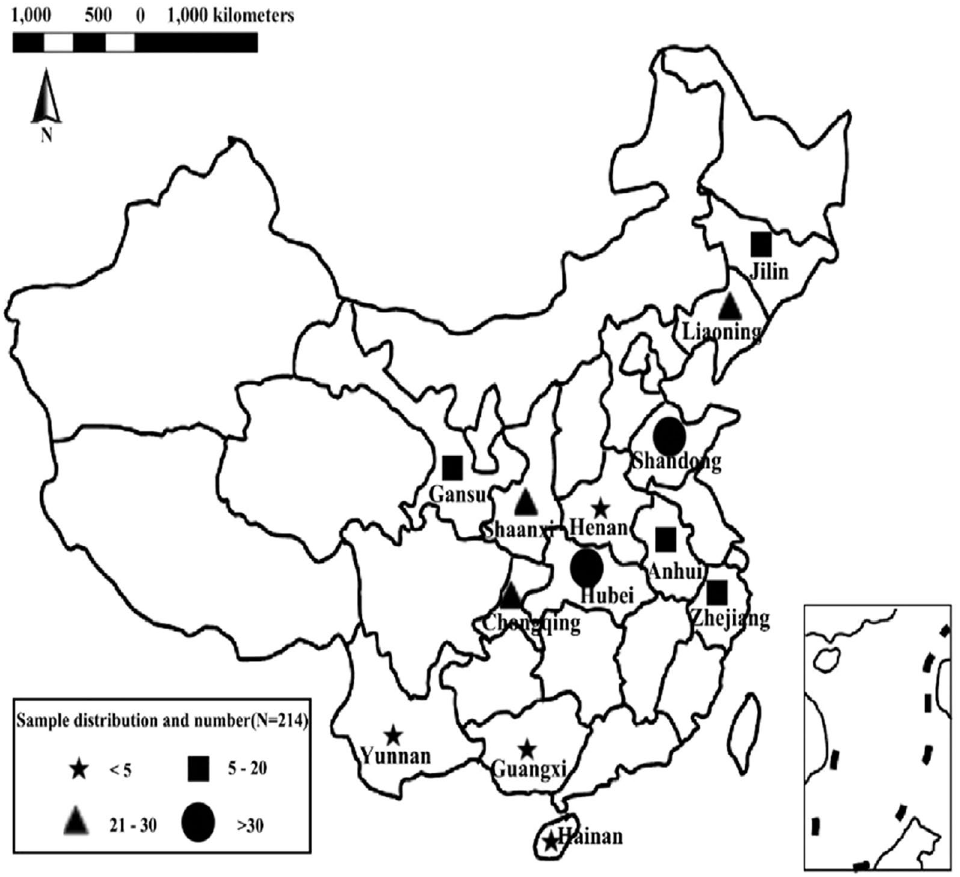
Figure 1. The region of the sample collected in China between 2016 and 2017 (N = 214). Five-pointed Stars represent the number of honeybee samples is less five. Squares represent the number of honeybee samples is between five and twenty. Triangles represent the number of honeybee samples is between twenty-one and thirty. Circles represent the number of honeybee samples is more thirty. We used this URL link (https:// cn. bing. com/ images/ search? q= blank% 20map% 20chi na% 20and% 20pro vince s& qs= HS& form= QBIRM H& sp= 1& pq= blank% 20map% 20chi na& sc=6- 15& cvid= 247BB D3C1C 2740E 6962B 42465 D5D56 34& first= 1& tsc= Image Hover Title) and added the fonts and shapes by Adobe Illustrator CC or 2019 Adobe Photoshop